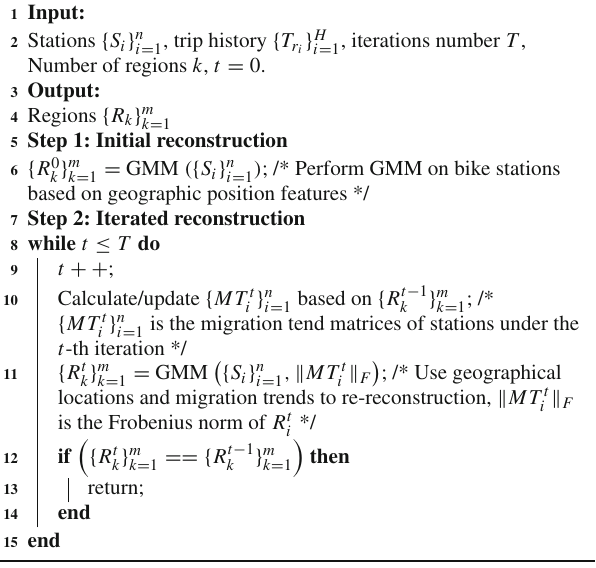
Algorithm 1: Region-reConStruction